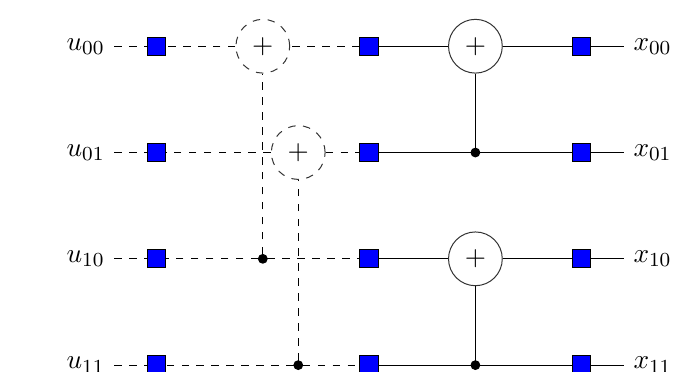
Figure 2 – Recursive construction of a 4 -dimentional polar transform from two unit